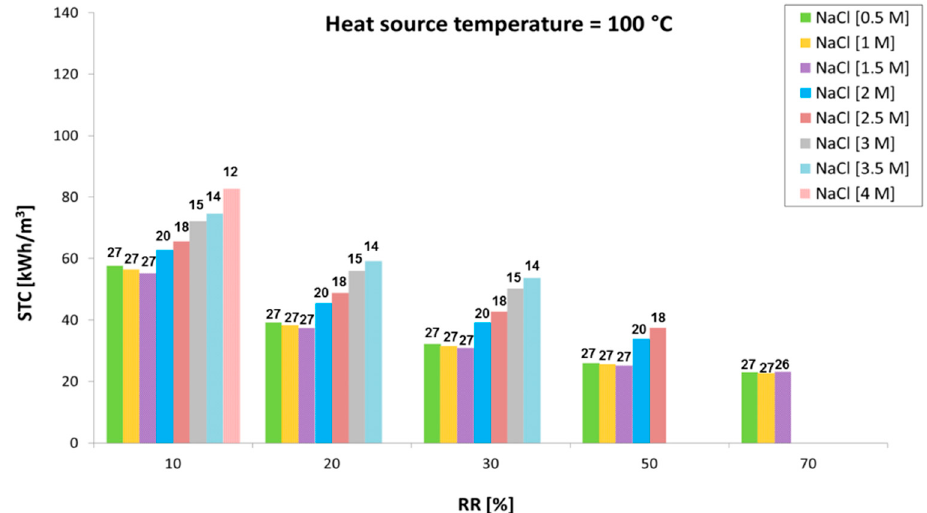
Figure 12. Variation of the specific thermal consumption with the recovery ratio at different inlet concentrations with a heat source at 100 °C.